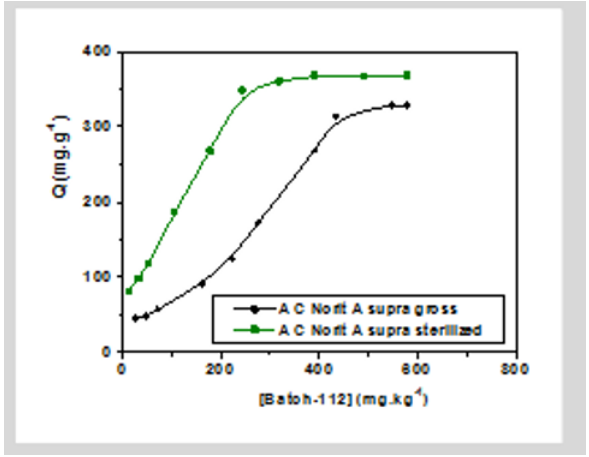
Fig. 7. Adsorption isotherms of chitosan (batch-112) on AC Norit A SUPRA EUR gross and Norit A SUPRA EUR sterilized aqueous solution pH = 4 at T = 298 K